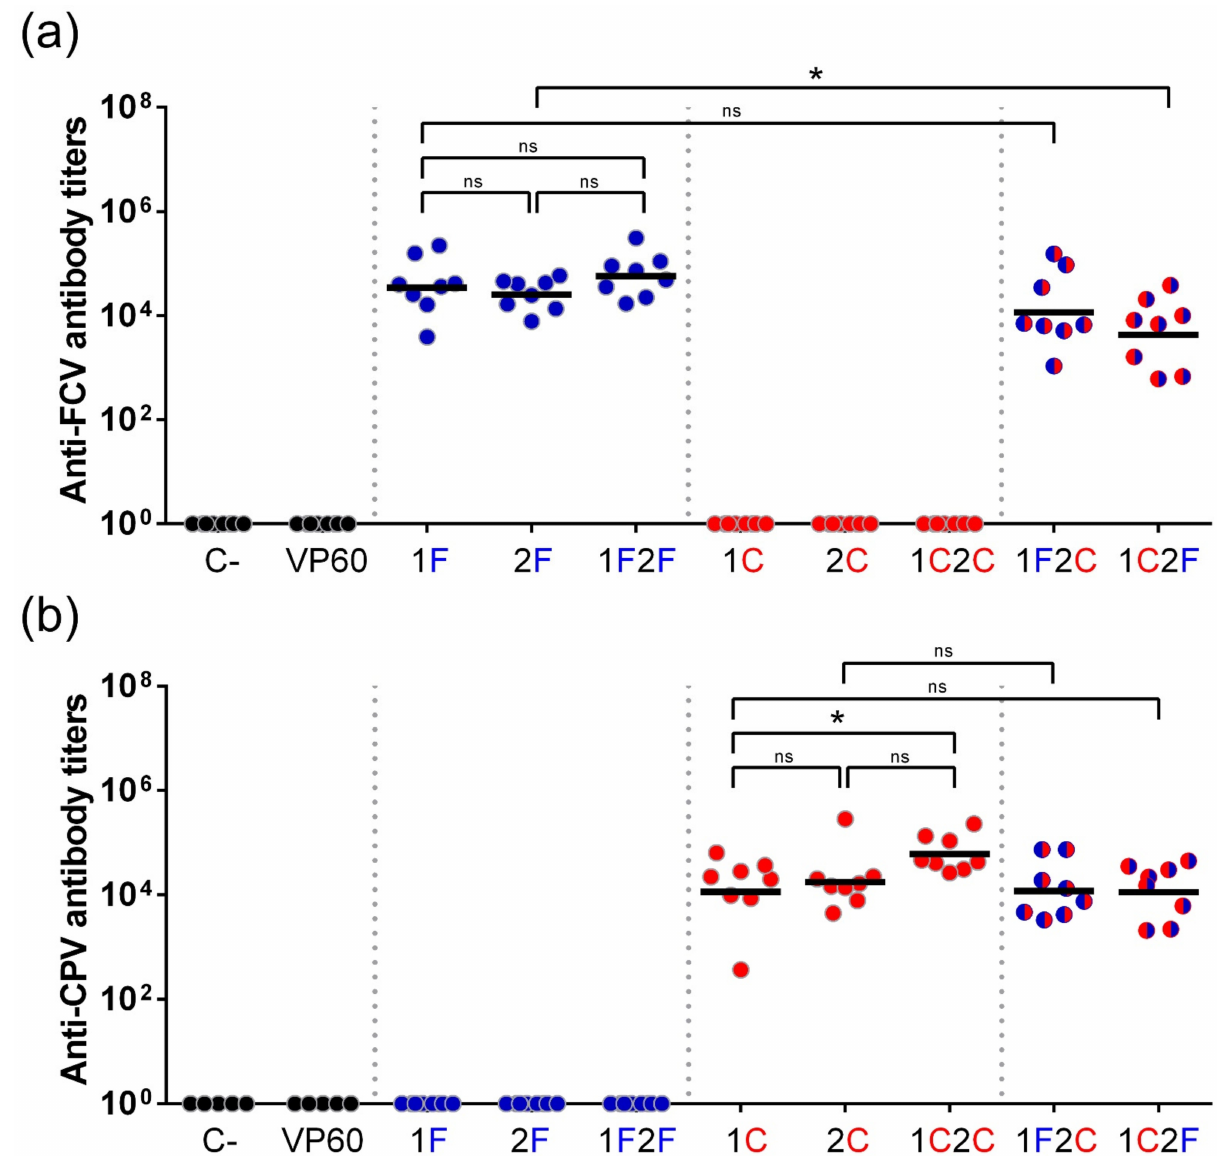
Figure 5. Serum IgG antibody titers against FCV and CPV target epitopes induced by immunization with the chimeric RHDV VLPs. Sera samples from groups of mice inoculated twice with the indicated VLPs were analyzed by ELISA. Anti-FCV ( a ) and anti-CPV ( b ) serum IgG antibody titers were determined using synthetic peptides encompassing the corresponding target epitopes (FCV22 and 2L21, respectively) as antigens. Each symbol represents the value for an individual mouse ( n = 5 for control groups and n = 8 for chimeric VLP groups). GMTs were calculated for all groups (solid lines). * or ns indicates that the differences between the indicated groups are statistically significant (0.01 < p < 0.05) or not significant ( p > 0.05),